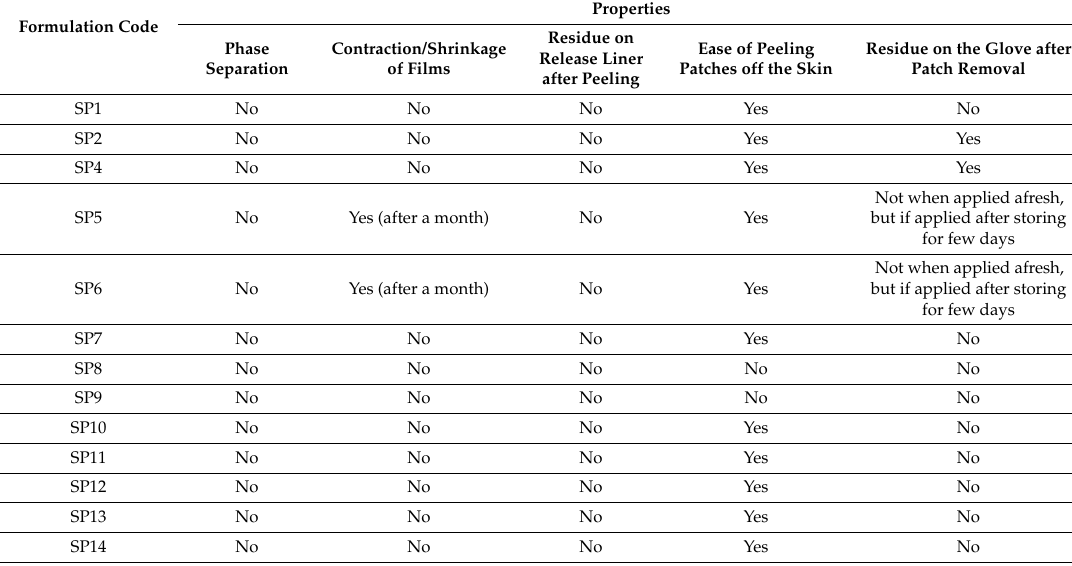
Table 5. Visual observations of TAF suspension